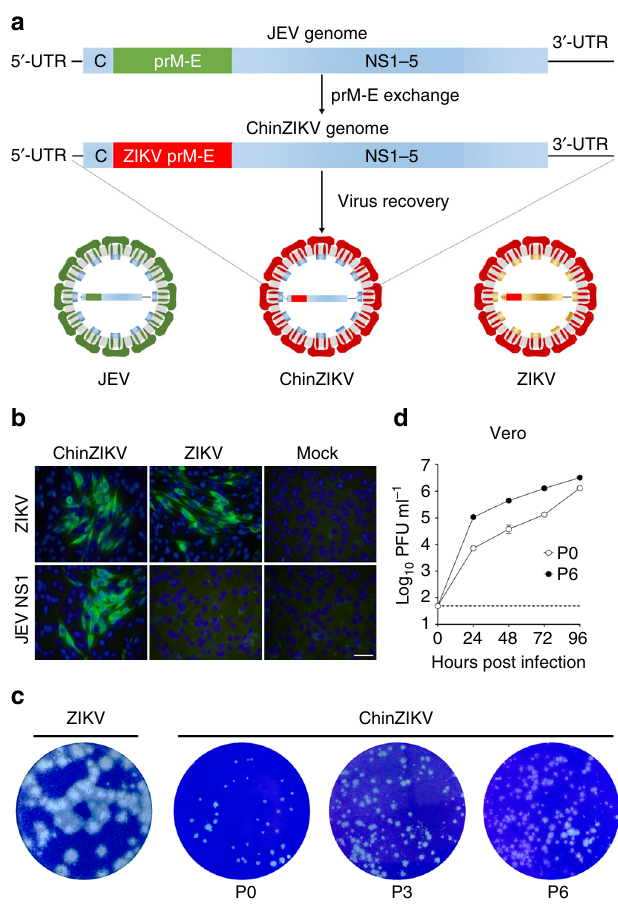
Fig. 1 Construction and characterization of ChinZIKV. a Strategy for construction of the chimeric ZIKV vaccine ChinZIKV and schematic representation of its genome. b Immunostaining of BHK-21 cells infected with ChinZIKV-, ZIKV-, or mock-infected at an MOI of 0.01 at 48 h post- infection with ZIKV patient anti-serum and JEV NS1 antibodies. Scale bar: 100 μ m. c Plaque morphology of ZIKV, the recovered ChinZIKV, and ChinZIKV at passages 3 and 6 on BHK-21 cells. BHK-21 cells were infected with the indicated viruses, and plaques were developed after 96 h. d Growth curves of the recovered ChinZIKV and ChinZIKV at passage 6 in Vero cells. Vero cells were infected with the indicated viruses at an MOI of 2 and the cell supernatants were collected at the indicated times for determination of virus titers by plaque assay using BHK-21 cells. The data are representative of at least three independent experiments and error bars indicate the